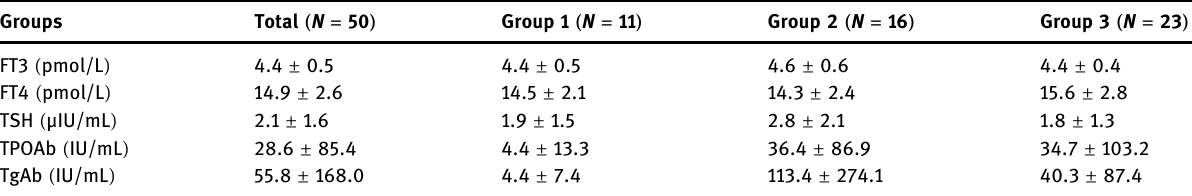
Table 4: Thyroid function indicators Groups